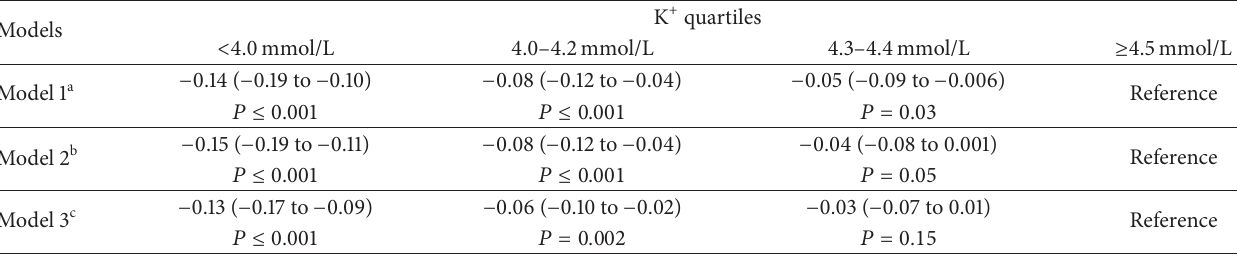
Table 3: Linear regression to determine the difference in HbA1c across K + quartiles.